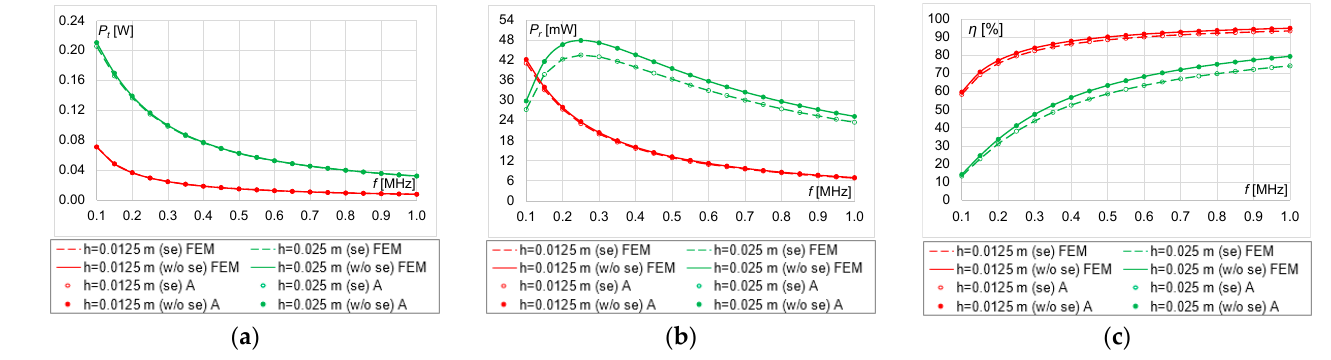
Figure 12. Results for n = 50 for the cases with and without skin effect: ( a ) P t , ( b ) P r , ( c ) η .